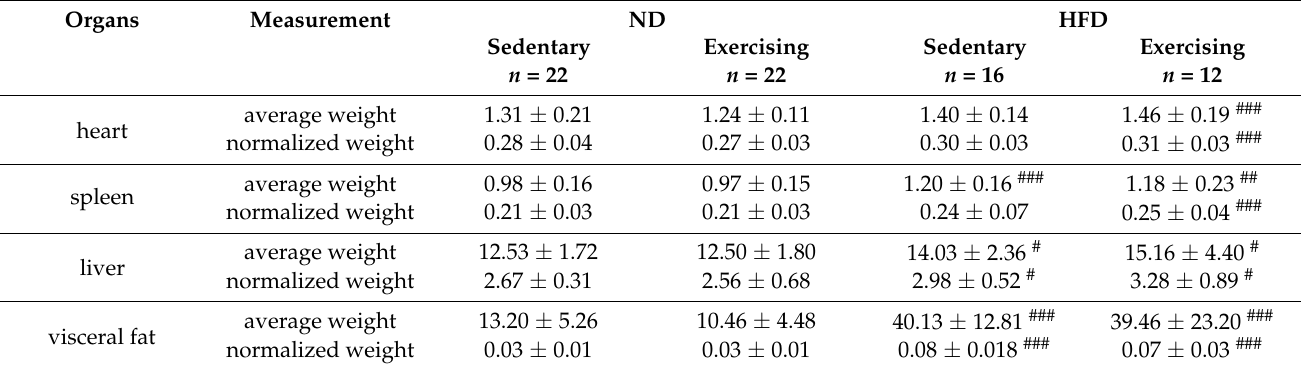
Table 1. Organ weight in female SD rats after 10 months of treadmill